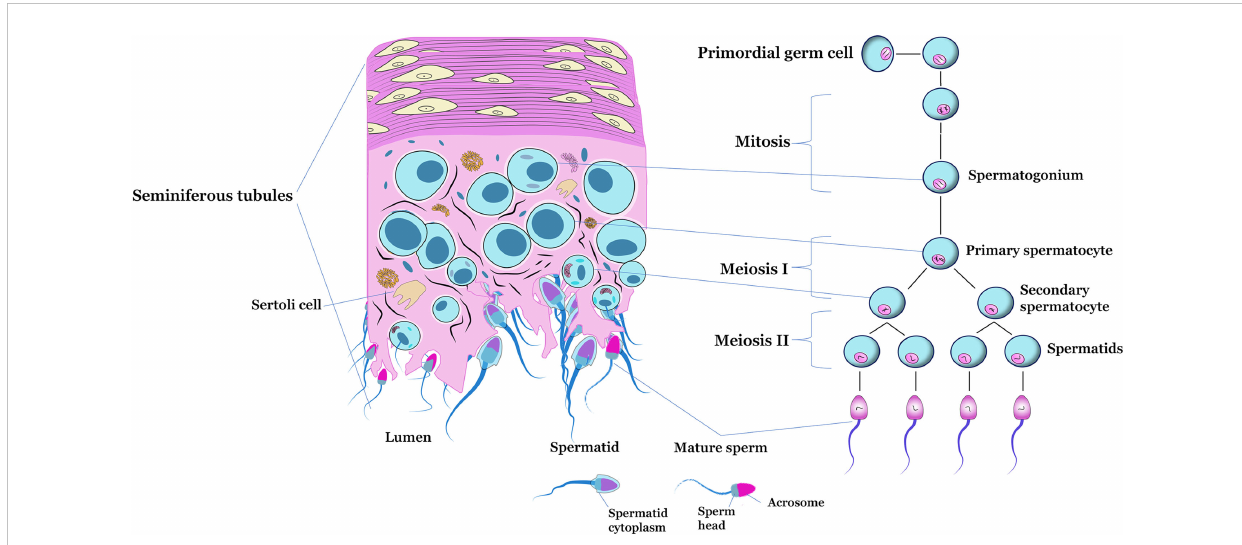
FIGURE 2 Schematic fi gure of a transverse section of the seminiferous tubule, highlighting the main cell types located inside (left). Representation of the of spermatogenesis (right).